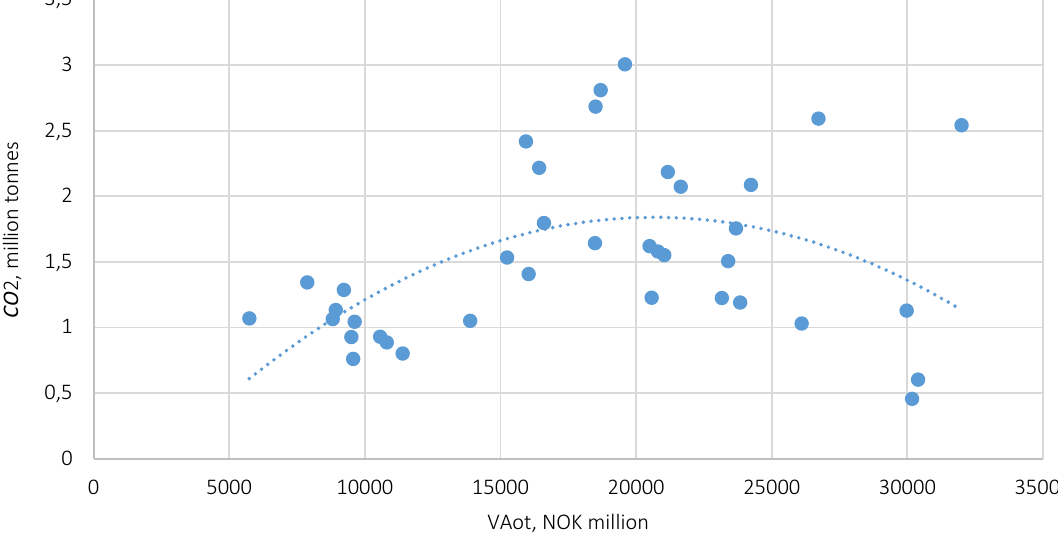
Figure 13. EKC for CO 2 emissions from international marine bunkers and ocean transport value added in